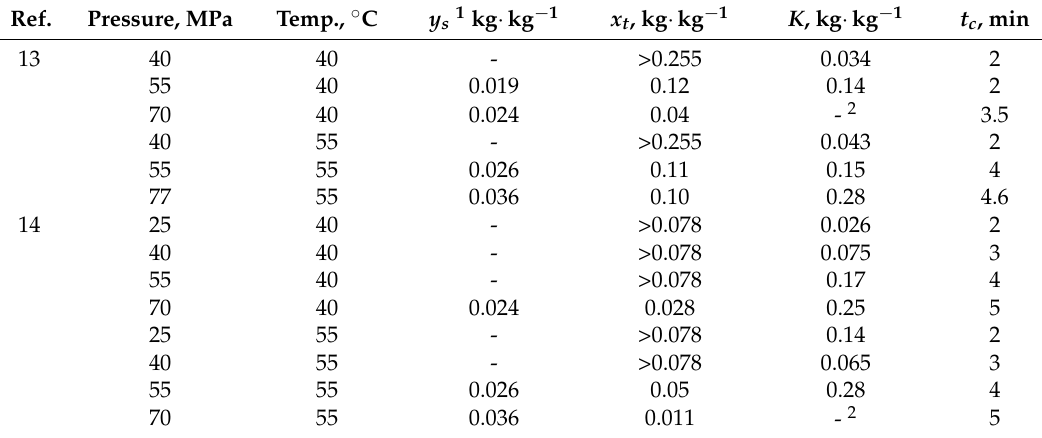
Table 3. Model parameters for the extraction of lipids from Nannochloropsis sp. [13] ( N = 180 g,